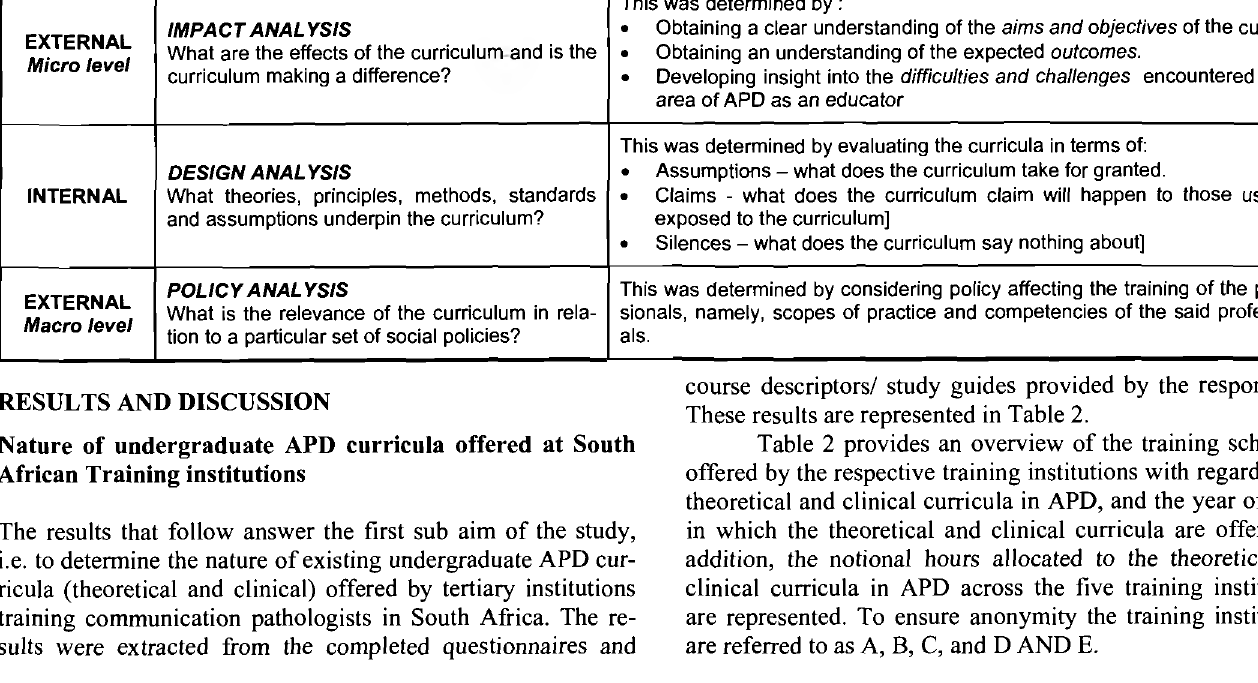
Table 2: Overview of the theoretical and clinical training schedules